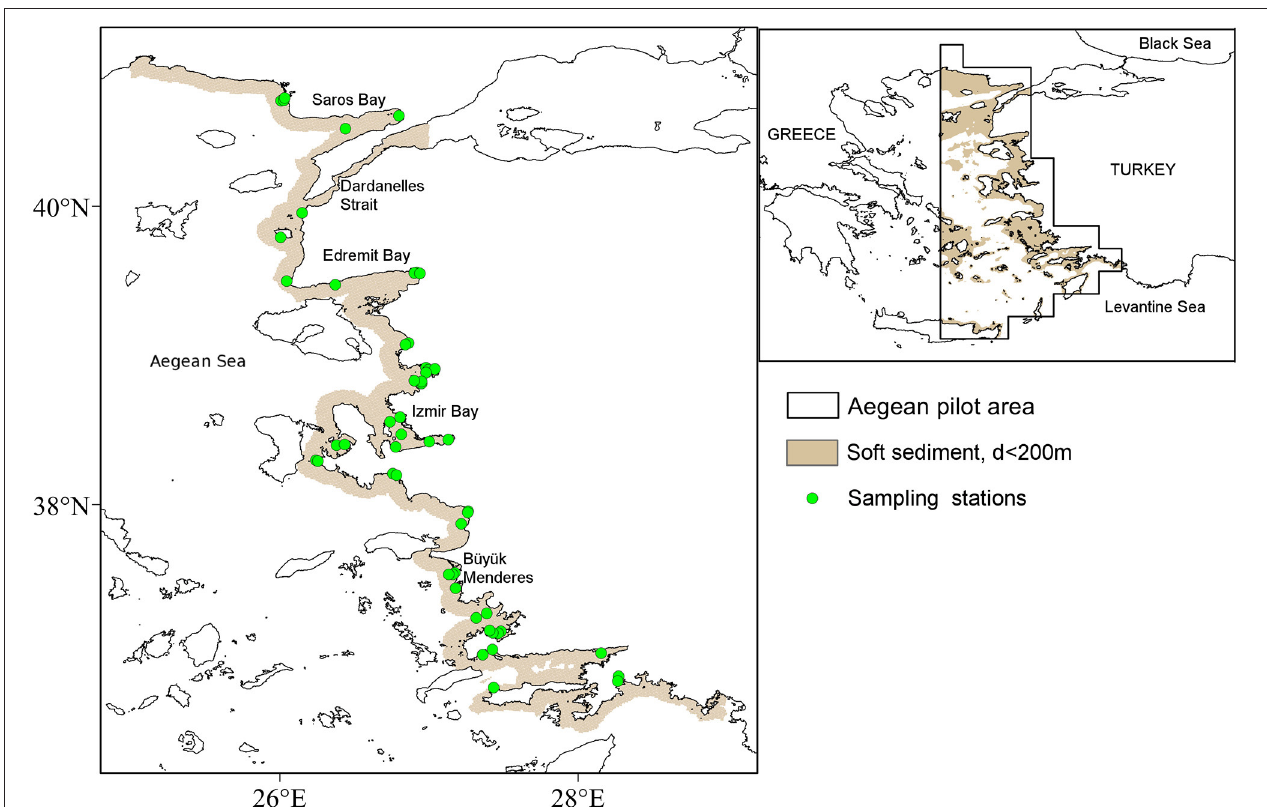
FIGURE 1 | Small map: Aegean Sea with the extent of the Aegean pilot area defined within the DEVOTES project and soft-sediment areas of the seabed with depths < 200m in light brown. Big map: Model prediction area (i.e., shallow, soft-sediment areas extending up to 10km from the mainland coastline) in light brown with sampled locations for benthic